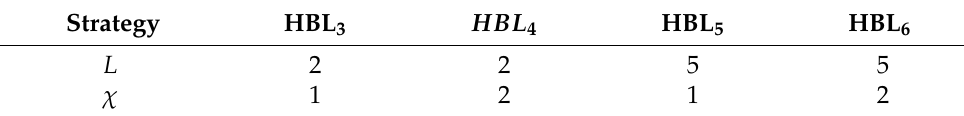
Figure 15. Correctly blocking spoof orders increases background-trader surplus and decreases manipulation profits. Table 6. A set of first HBL variation with different price level blocking